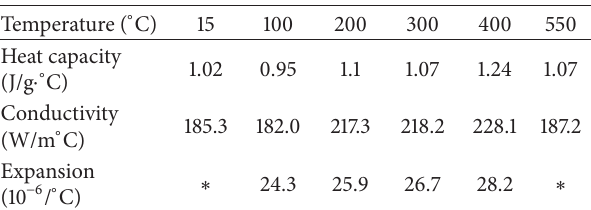
Table 2: Thermal conductivity and thermal expansion coefficient of 7A85 aluminum alloy.